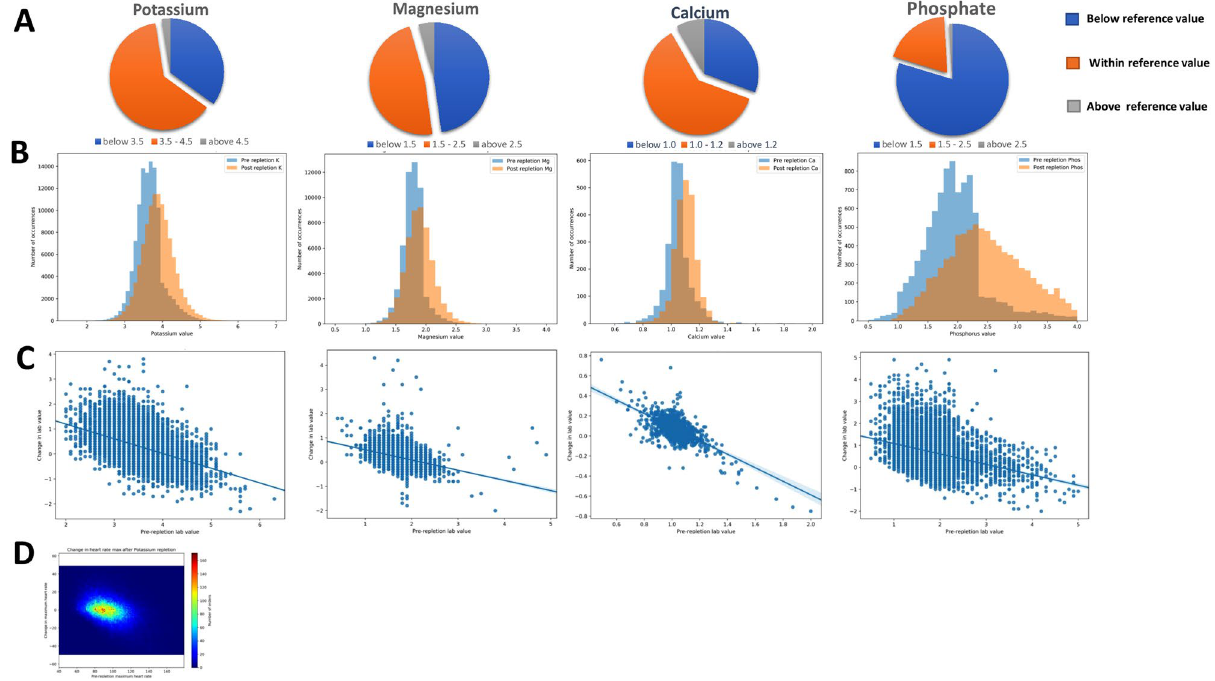
Figure 1. Electrolyte replacement thresholds and triggers. Majority of a replacement for potassium, magnesium, and calcium but not phosphate happened within reference ranges ( A ) and resulted in modest at best post-replacement changes in electrolytes serum level ( B ). Pre-repletion serum level correlated modestly with a post-repletion increase in lab value for all four electrolytes though these effects were relatively small ( C ). Replacement of potassium did not result in a decrease in tachyarrhythmias before and after repletion ( D